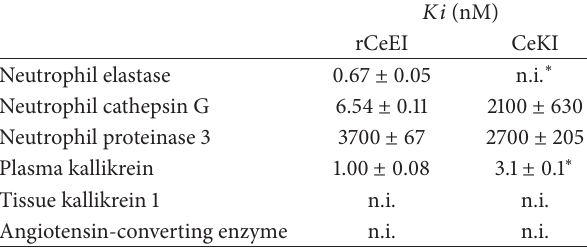
Table 1: Specificities of rCeEI and CeKI on enzymes.